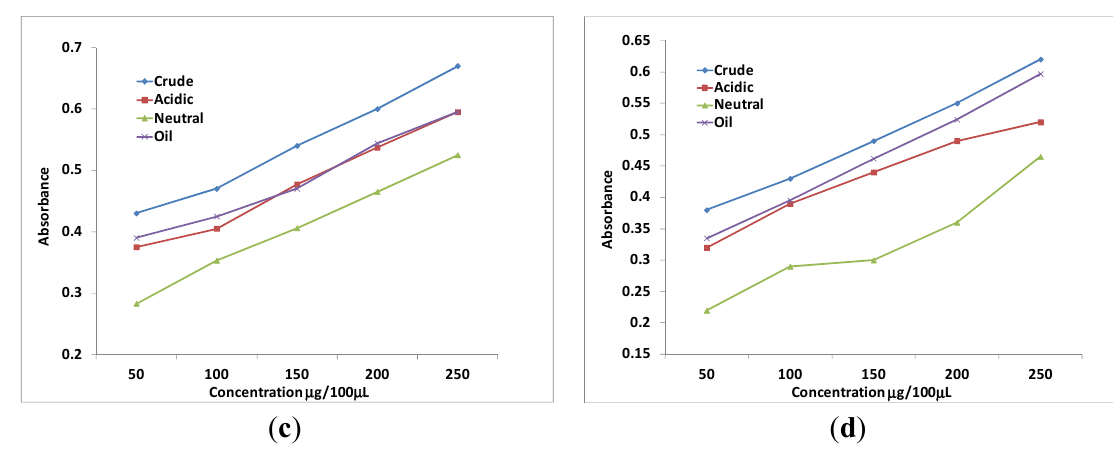
Table 4. % Fe 2+ chelating activity of the crude extract, acidic and neutral fraction and oil. Sample (µg/100